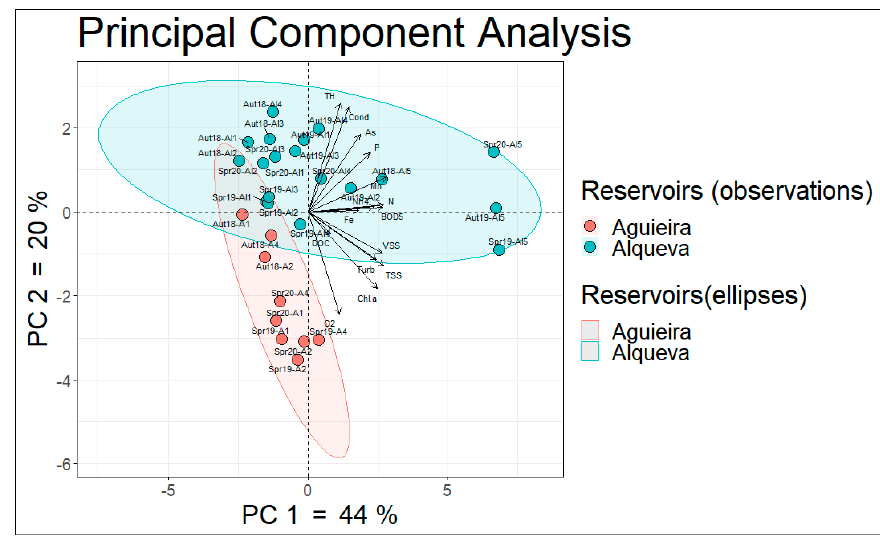
Figure 3. PCA of in-situ data from both reservoirs. O 2 is oxygen concentration (mg L − 1 ), Cond is